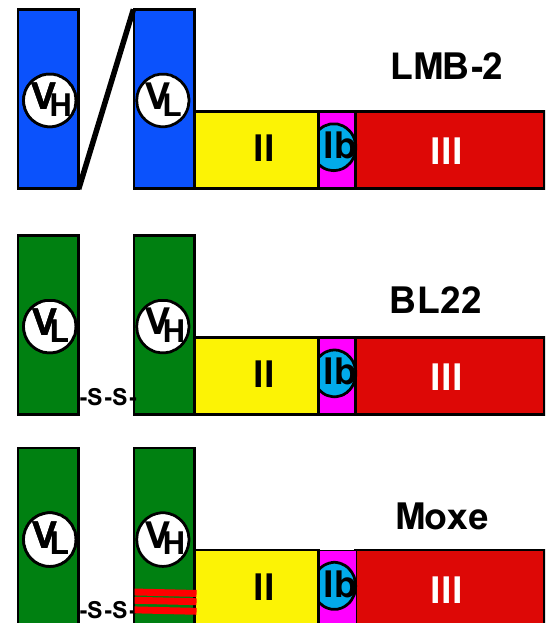
Figure 1. Recombinant immunotoxins targeting hematologic malignancies. LMB-2 development began in 1989 and led to the anti-CD25 single-chain recombinant immunotoxin LMB-2, also called anti-Tac(Fv)-PE38 [99–101]. The variable domains of the anti-CD25 Mab anti-Tac are connected by a peptide linker (GGGGS) 3 , and a shorter peptide connects V L with the 38 kDa truncated form of PE